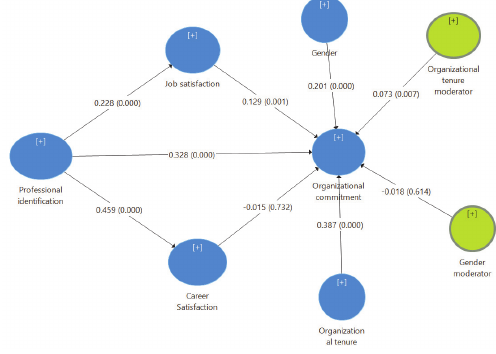
Fig. 12. The regulatory role of regulatory variables (Bootstrap out Smart PLS)